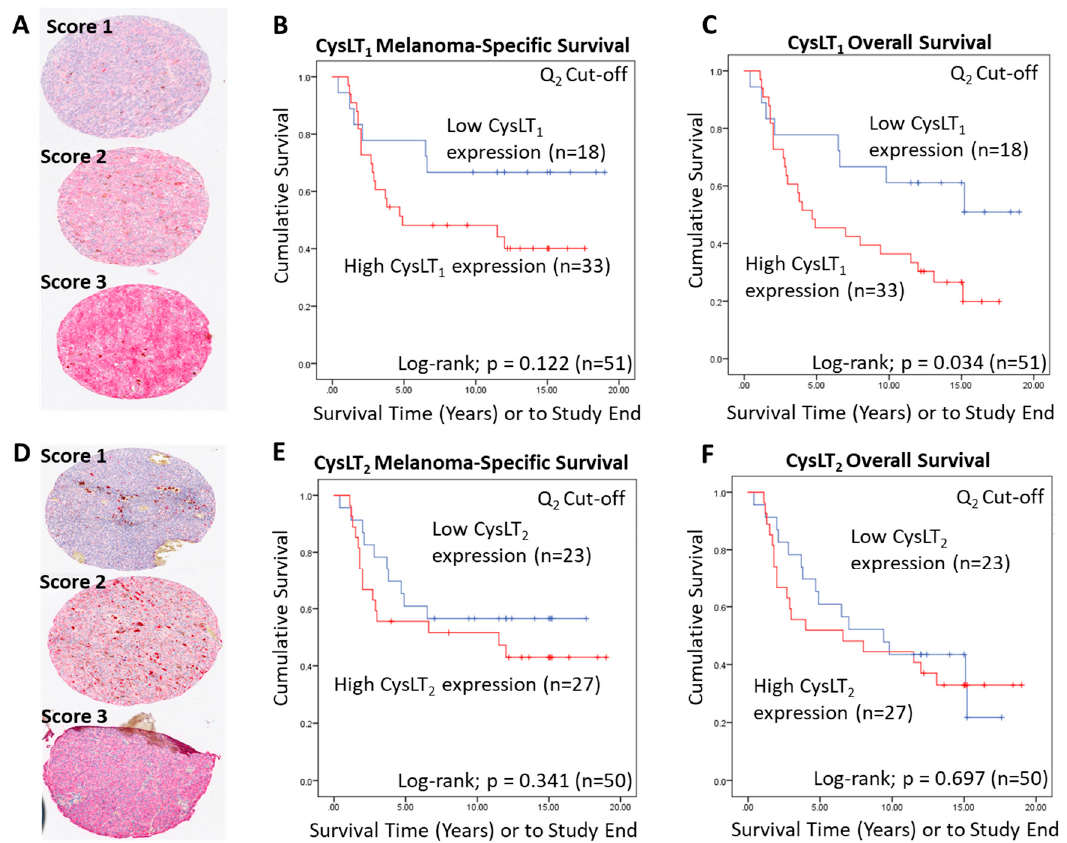
Figure 2. Examination of the prognostic value of CysLT 1 and CysLT 2 protein expression in primary UM samples by manual pathology. ( A ) Representative cores from the UM patient TMA designated with a score of 1, 2, or 3 for CysLT 1 staining intensity. ( B ) Kaplan–Meier survival curve stratified based by high (red) or low (blue) CysLT 1 expression and death by metastatic melanoma ( n = 51; Log-rank; p = 0.122; HR 2.04; 95% CI 0.81–5.12). ( C ) High expression of CysLT 1 (red) is significantly associated with reduced overall survival in primary UM patients ( n = 51; Log- rank; p = 0.034; HR 2.34; 95% CI 1.04–5.25) ( D ) Representative cores from the TMA designated with a score of 1, 2 or 3 for CysLT 2 staining intensity. ( E ). Kaplan–Meier survival curve stratified based by high (red) or low (blue) CysLT 2 expression and death by metastatic melanoma ( n = 50; Log-rank; p = 0.341; HR 1.15, 95% CI 0.58–2.28). ( F ) Kaplan–Meier survival curve stratified based by high (red) or low (blue) CysLT 2 expression and death by any cause ( n = 50; Log-rank; p = 0.697; HR 1.15; 95% CI 0.58–2.28). The median was used as the cut-off point for high versus low expression for all Kaplan–Meier survival curves. Number of events indicates the number of deaths due to metastatic melanoma ( B , E ). Number of events indicates the number of deaths due to any cause ( C , F ).